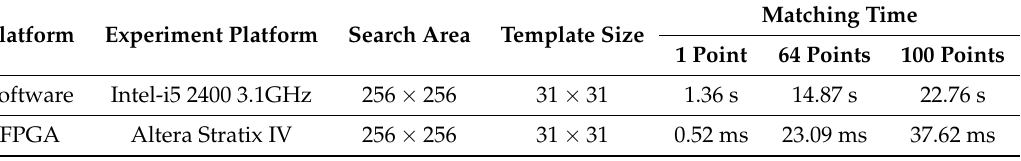
Table 4. Comparison of simulation time between hardware and